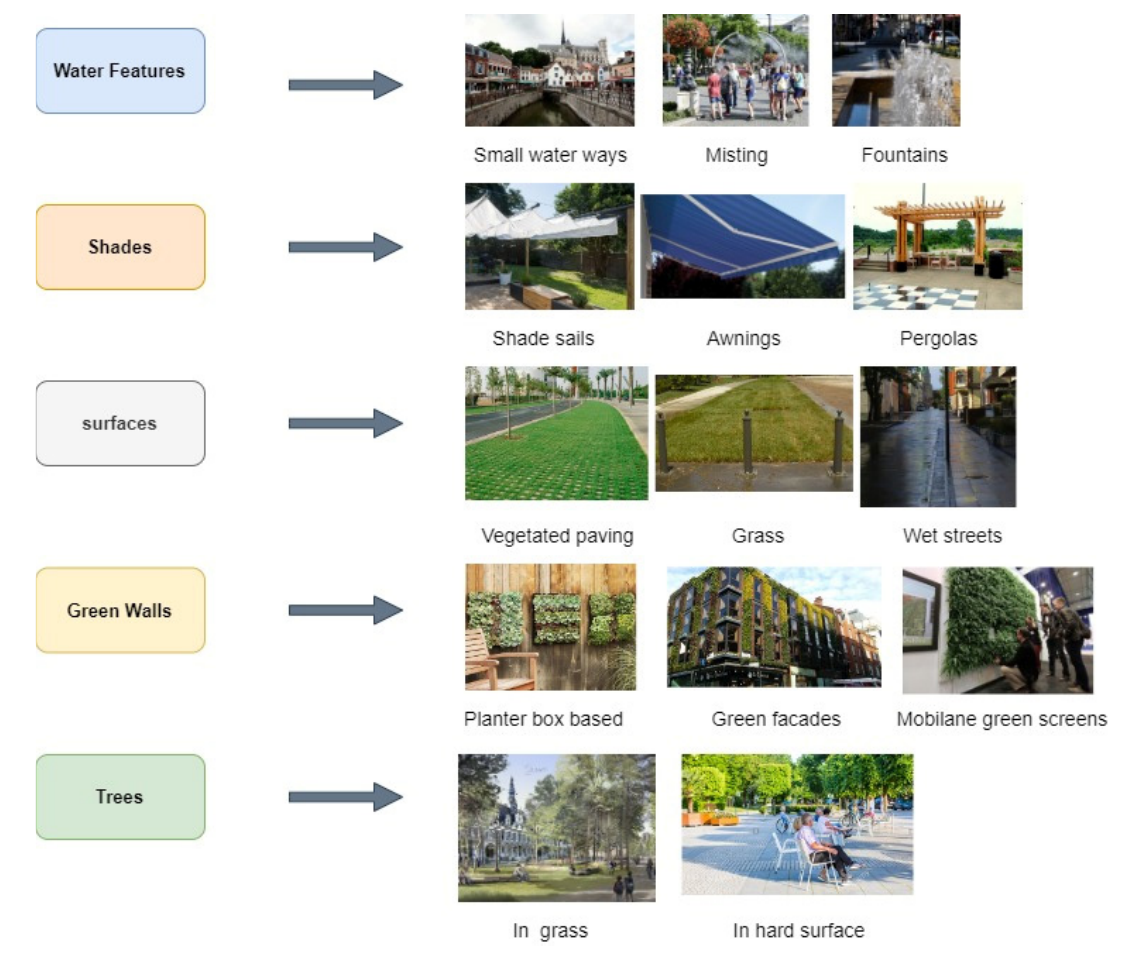
Figure 1. Type of heat resilience interventions.